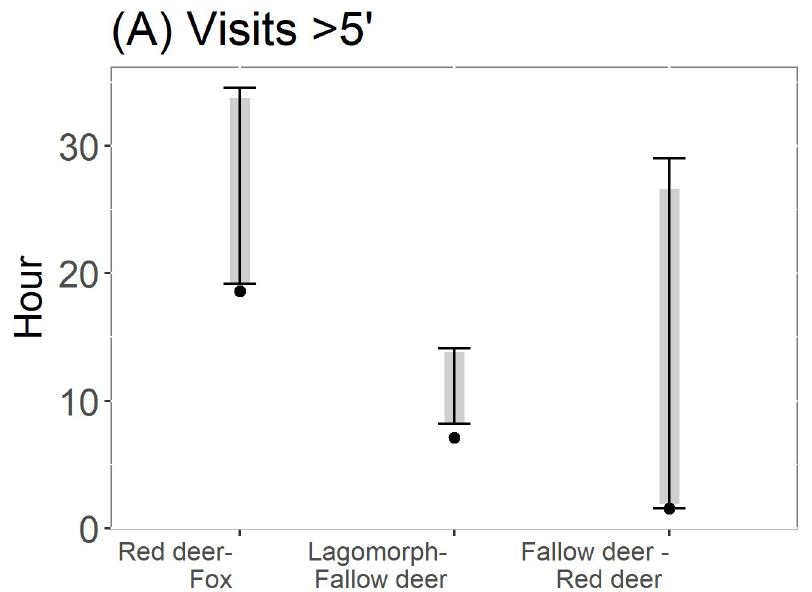
Fig 6. Significant interactions between frugivores of Pyrus bourgaeana resulting from applying null model 3. Black dots indicate the observed mean time differences (OMTD). Black lines and grey bars represent the expected 95% and 90% intervals of time elapsed between visits, respectively. (A) Interactions derived from the whole set of visit data.